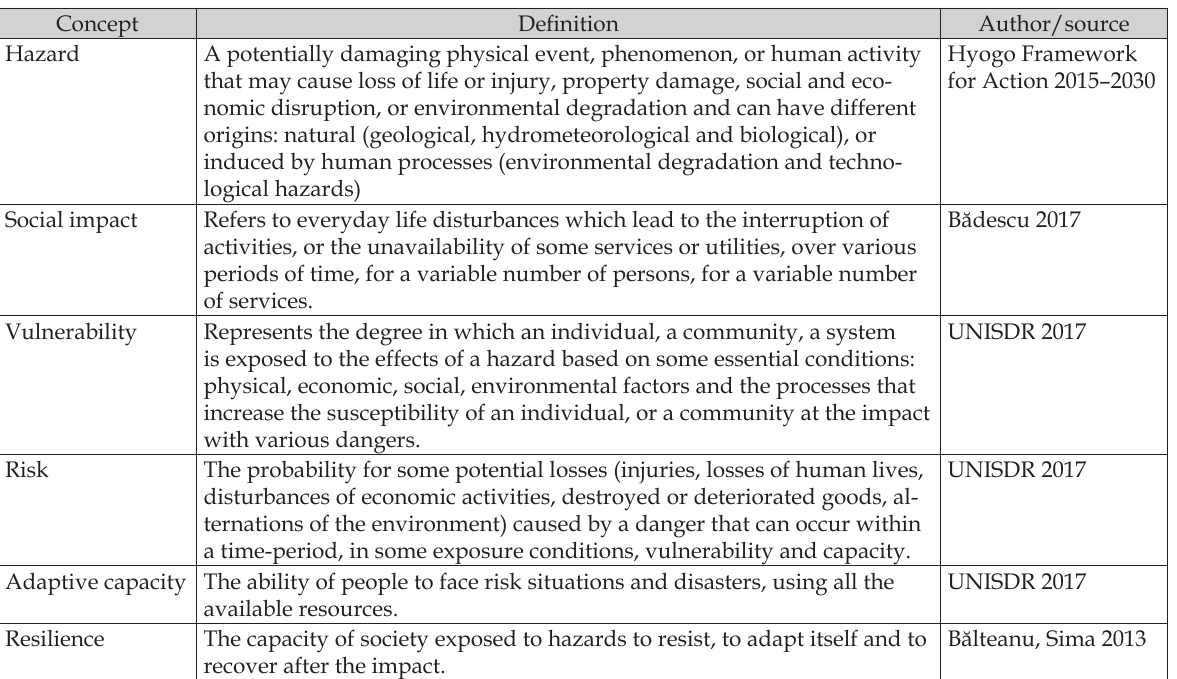
Fig. 1. Classification of social risks. Table 3. Key concepts in social risk